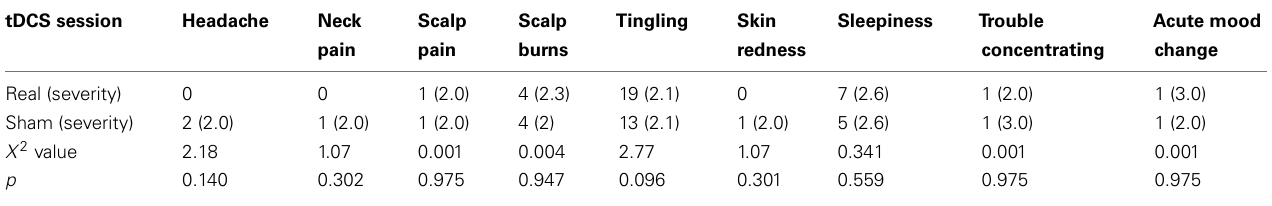
Table 2 | Number of participants reported tDCS side